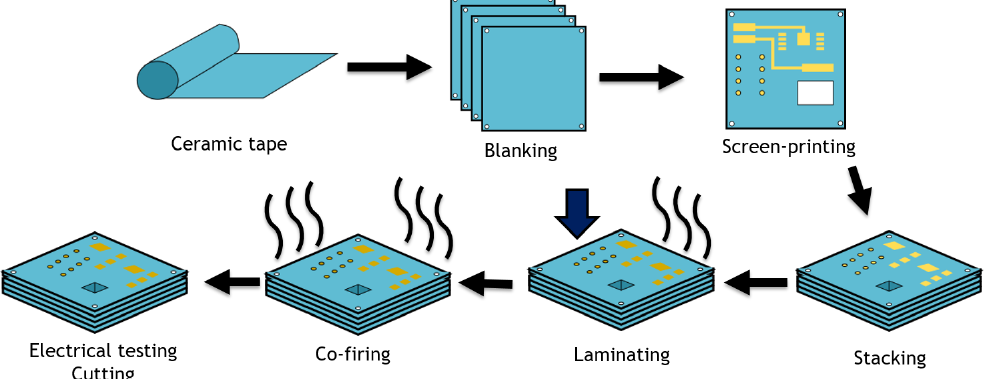
Figure 1. Schematic drawing of LTCC manufacturing process